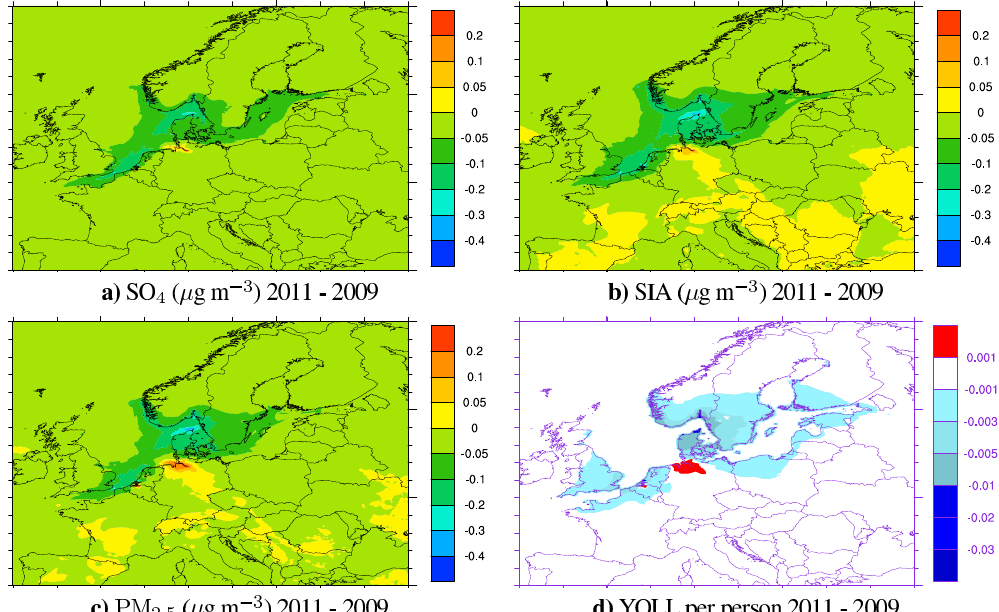
Figure 6. Model calculated difference, 2011 vs. 2009 ship